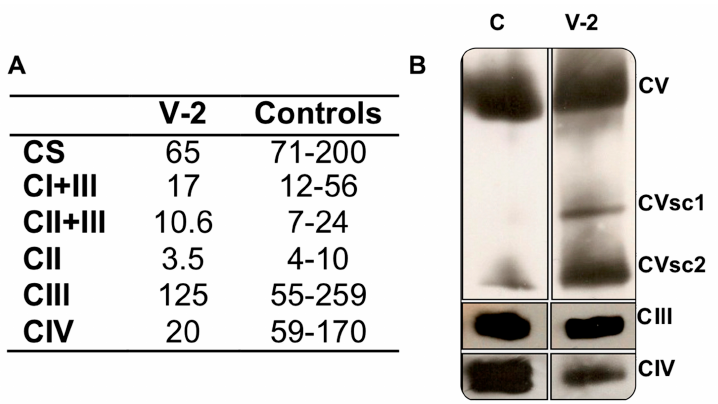
Figure 2. Muscle biochemistry. ( A ) Respiratory complex I + III (CI + III), II + III (CII + III), II (CII), III (CIII), IV (CIV) and citrate synthase- (CS) specific activities (nmol / min x mg protein) of the Leigh syndrome (LS) patient (V-2) and controls. ( B ) Respiratory complex levels of V-2 and a control ( C ). CVsc1 and 2 are code for CV sub-complexes 1 and 2, respectively.